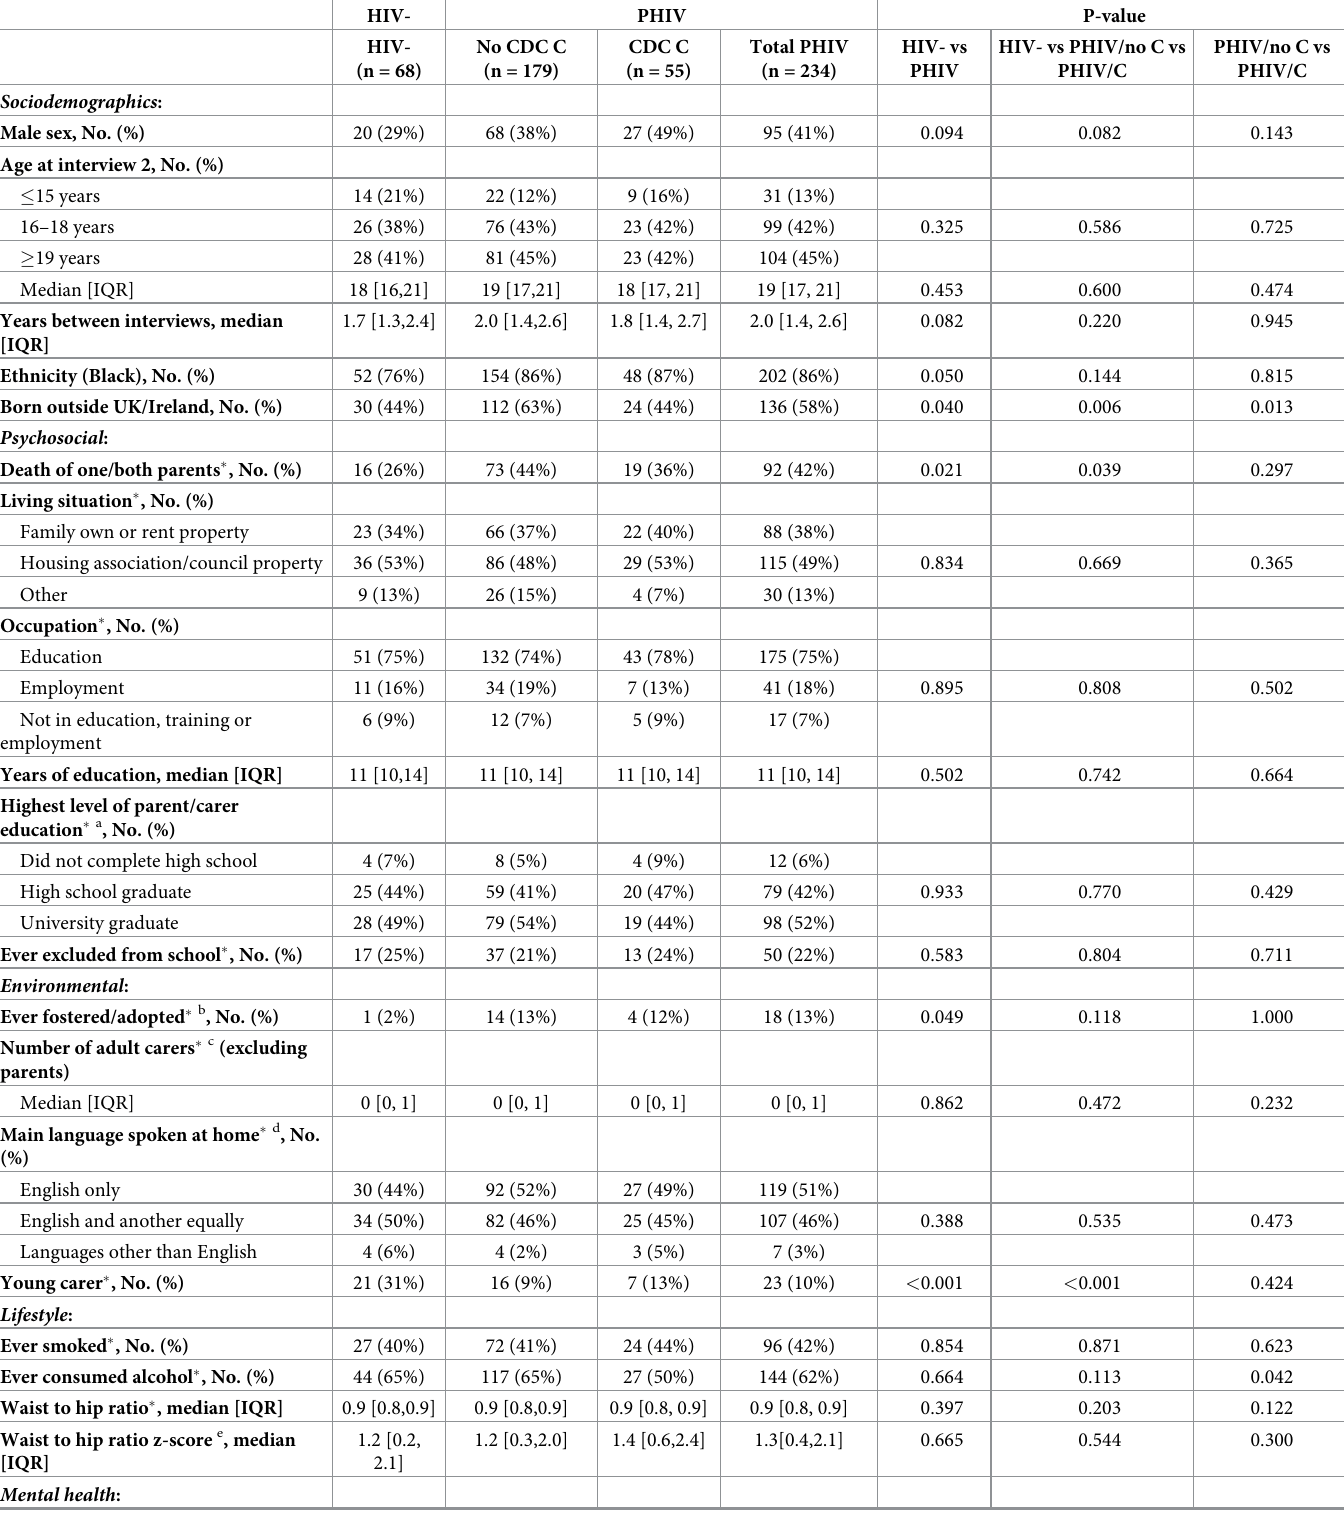
Table 1. Characteristics of participants by HIV and CDC